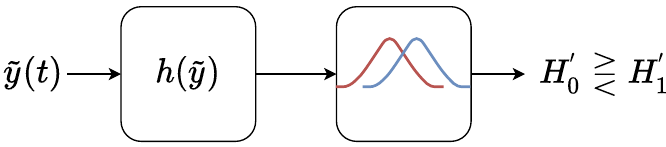
Figure 5. Detection process including transformation